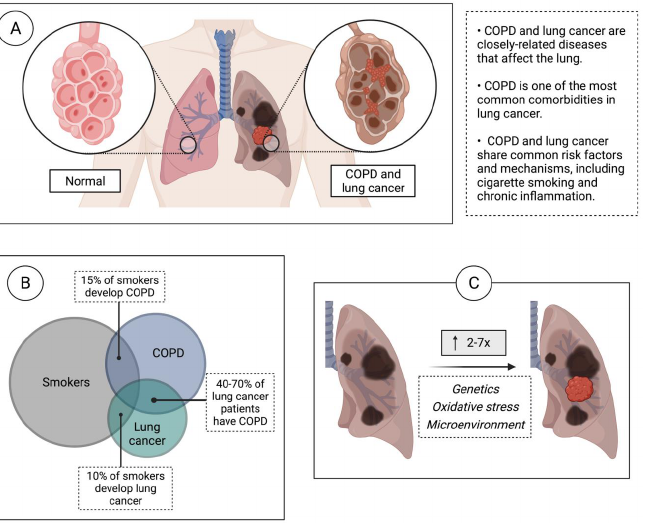
Figure 1. COPD confers a greater risk for lung cancer development. ( A ) COPD and lung cancer are closely linked diseases that affect the lung. ( B ) There is a large overlap between COPD and lung cancer in smokers. While a subset of smokers develop COPD or lung cancer, a significant propor- tion (40 – 70%) of lung cancer patients have COPD. ( C ) COPD confers a 2-7x greater risk of devel- oping lung cancer, independent of smoking history. Possible shared mechanisms that may contrib- ute to this process are genetics, oxidative stress, and microenvironmental factors. 2. Genetic Mechanisms of Lung Cancer Development in Individuals with COPD Genetic alterations as well as the deregulated expression of protein-coding and non- coding RNA genes have been extensively reported for the subtypes of lung cancer [23 – 25]. While the genetic contribution to COPD is not fully understood [26], studies have linked the co-morbidity of lung cancer and COPD [12]. For example, two percent of COPD patients have an alpha-1 antitrypsin (A1AT) deficiency that results in unopposed proteo- lytic activity by neutrophil elastase (NE), which has been linked to increased lung cancer progression and metastasis [27,28]. Genome-wide association studies (GWAS) have also identified several genetic variants that might increase the susceptibility to developing both COPD and lung cancer (Figure 2A); however, the estimated heritability of both re- mains low [29,30]. Polygenic risk scores (PRSs) show a high association between genotype and the onset and severity of developing COPD, both in European and in non-European populations [31], with multi-ancestry PRS performing better than ancestry-specific ones [32]. Other variants include certain shared single nucleotide polymorphisms (SNPs) that also appear to increase the risk of both COPD and lung cancer development, particularly those found on chromosome 12q25 [33] and chromosome 6 [34]. Another cluster of genes, specifically the CHRNA5 - CHRNA3 - CHRNB4 loci on chromosome 15, encode the nicotinic